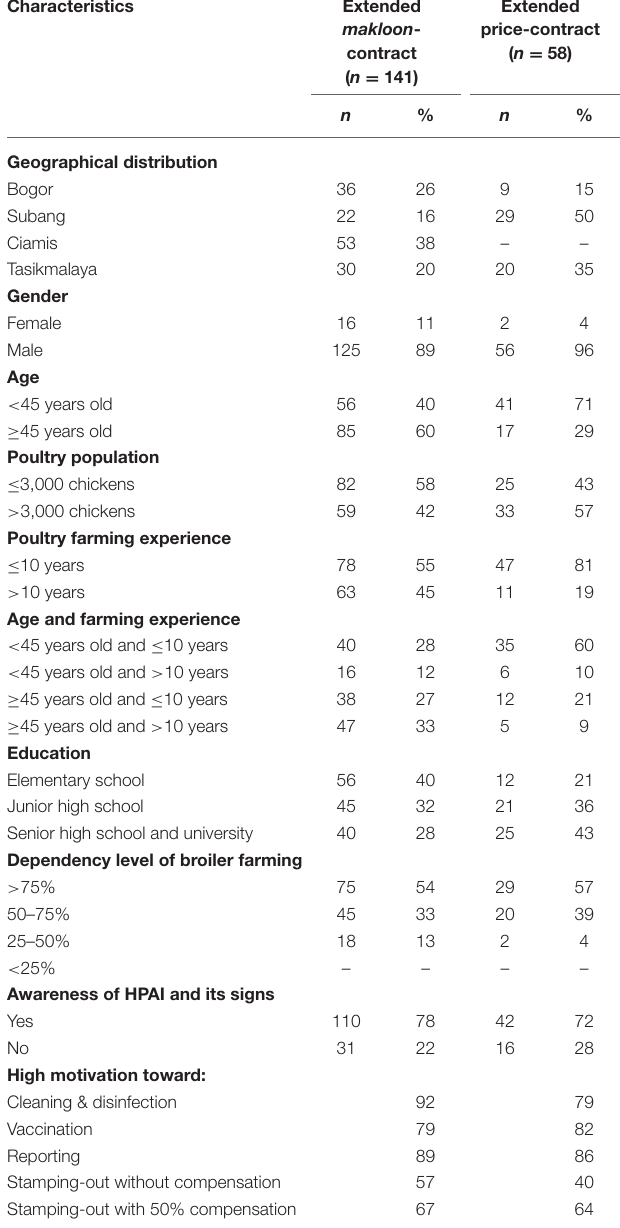
TABLE 2 | Descriptive statistics of farmer and farm characteristics, and farmers motivations for each business type.